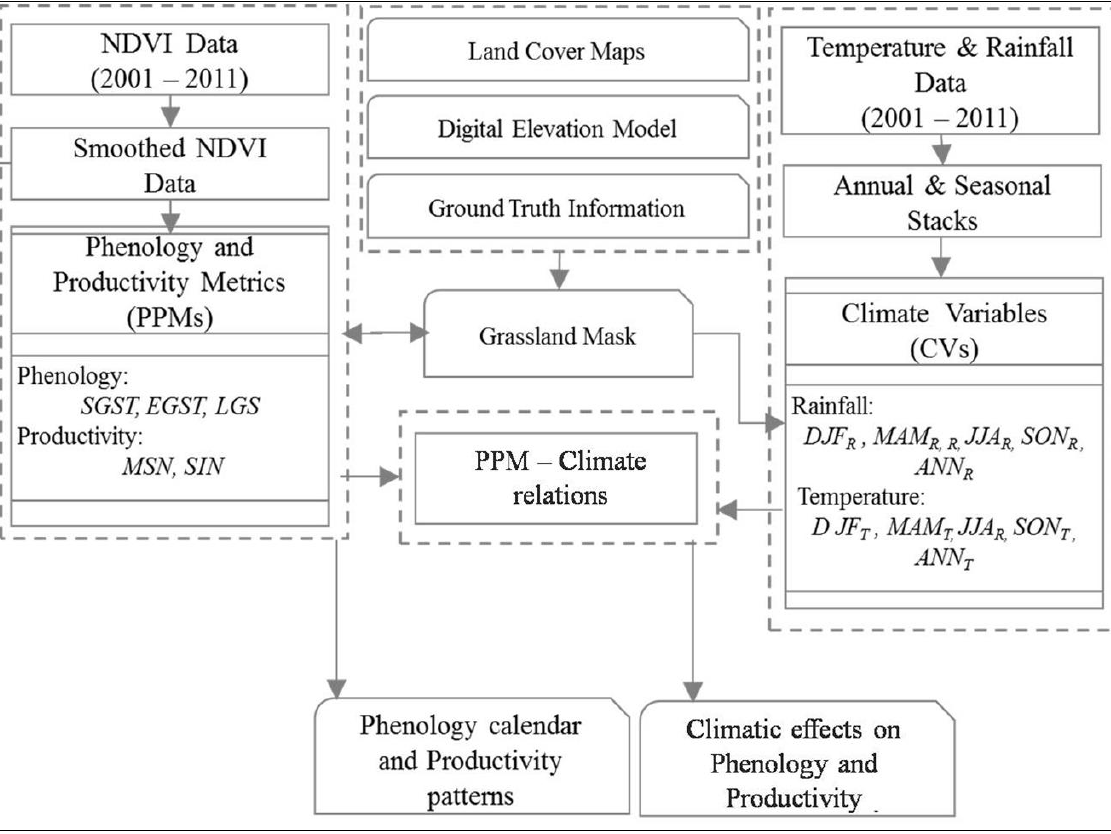
Figure 2. Summary of methodology (see Supplementary 1 for detailed